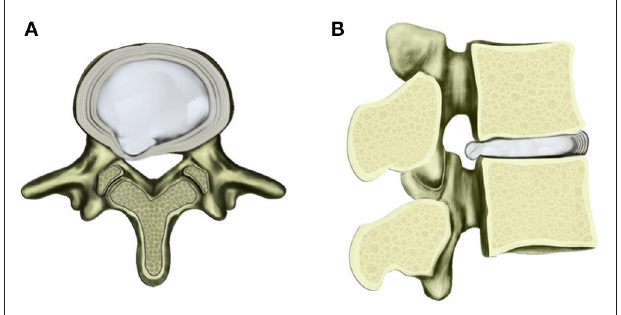
FIGURE 3 | Schematic diagram of contained herniated lumbar disc with transverse (A) and sagittal views (B) . Under multiple factors, the nucleus pulposus protrudes toward posterior and lateral direction with AF fibers ruptured to a certain